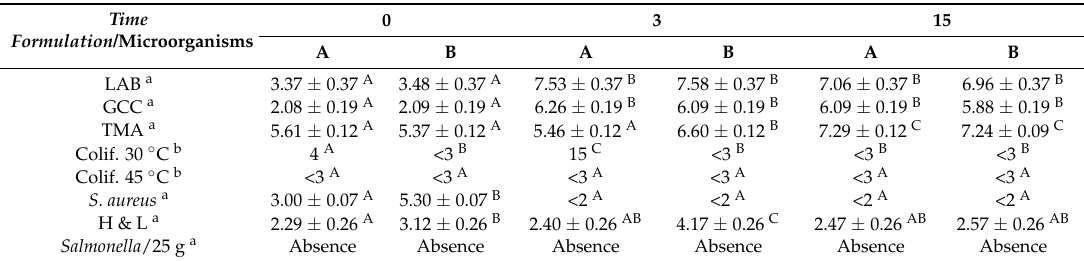
Table 3. Total microorganism counts in spontaneously goat meat fermented sausages at different times (0, 3, and 15